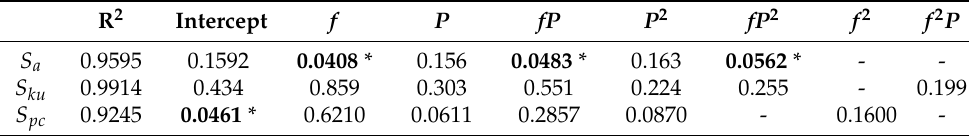
Figure 12. Plot of the regression functions of microhardness. Results of ANOVA analysis show that 𝑓 and 𝑃 are not statistically significant for H V ( p -value 0.359 and 0.106). Table 10 presents the R 2 value and significance analysis ( p - value) for individual structural elements of regression models for H V . The R 2 value shows the high accuracy of the models. The results indicate that not all structural elements of the model are statistically significant. However, attempts to omit them again in the model resulted in a decrease in the quality of the model—a decrease in the value of R 2 .